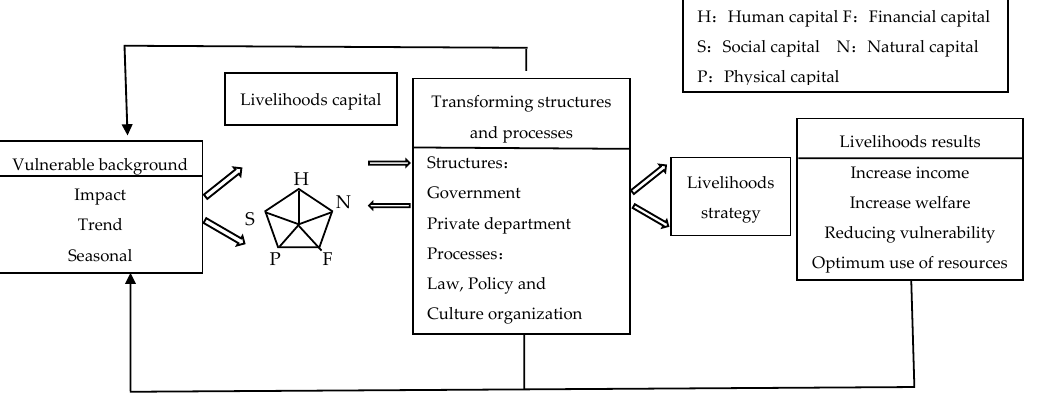
Figure 1. Sustainable Livelihoods Figure 1 . Sustainable Livelihoods Framework.